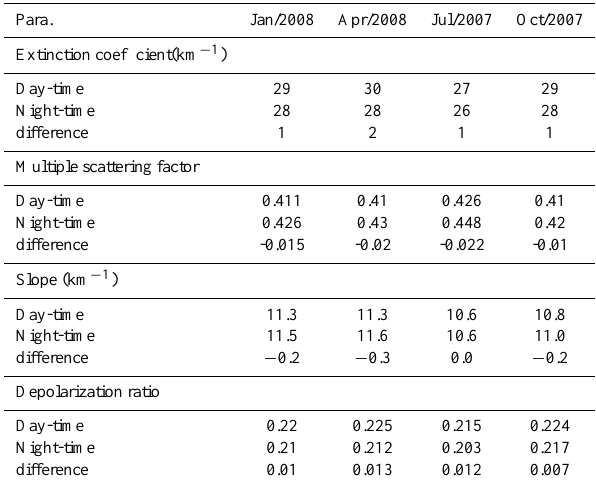
Fig. 8. The height dependency of global mean depolarization ratio for all level water clouds. The solid lines are for daytime, thicker dashed lines are for nighttime, thinner dashed lines are for the difference between day and nighttime. The values in the brackets are the global mean depolarization ratio for all water clouds.